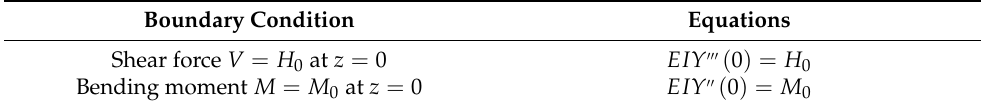
Table 1. Boundary conditions used for elastic solution.